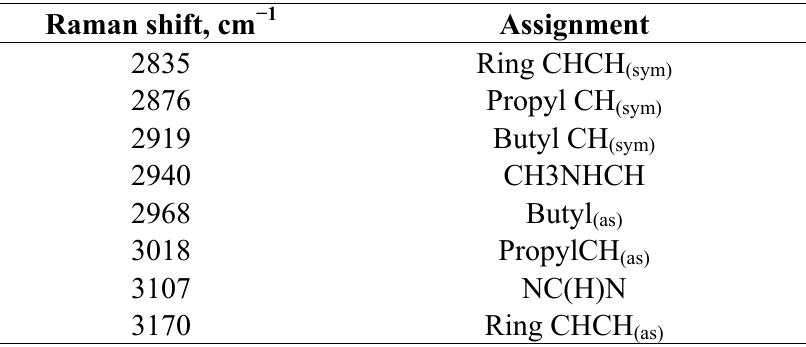
Table 2. Vibrational spectra of IL